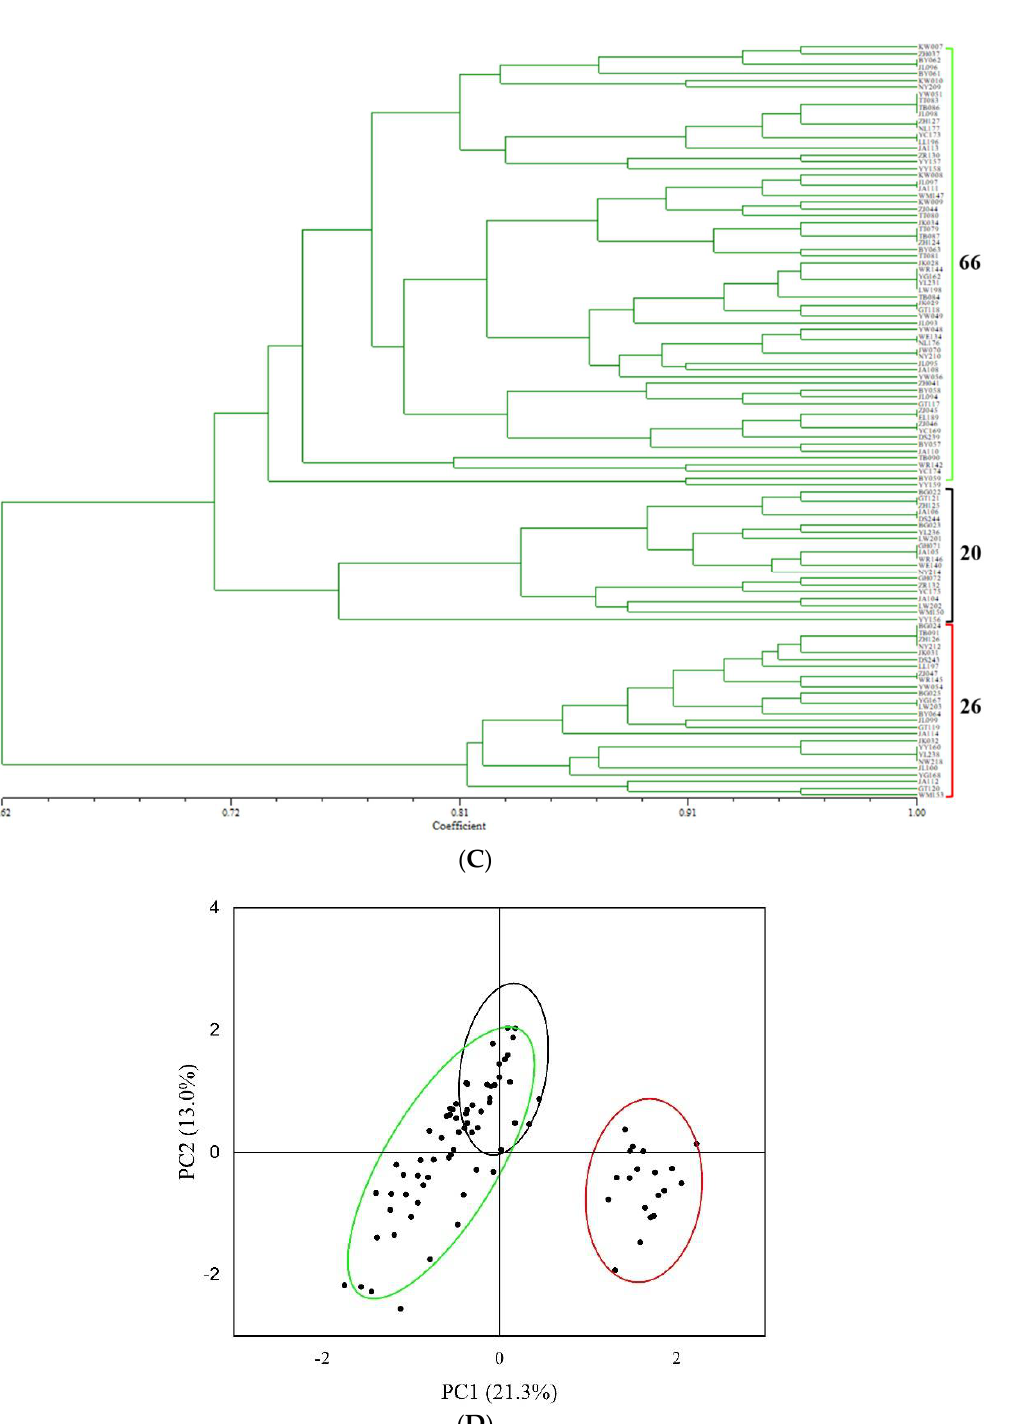
Figure 1. ( A ) Morphological trait diversity of Tartary buckwheat seeds. ( B ) The heat map of ten morphological traits of seeds. ( C ) UPGMA dendrogram of morphological traits in Tartary buckwheat landraces seeds. ( D ) Principal component analysis (PCA) of 112 Tartary buckwheat accessions based on morphological traits.